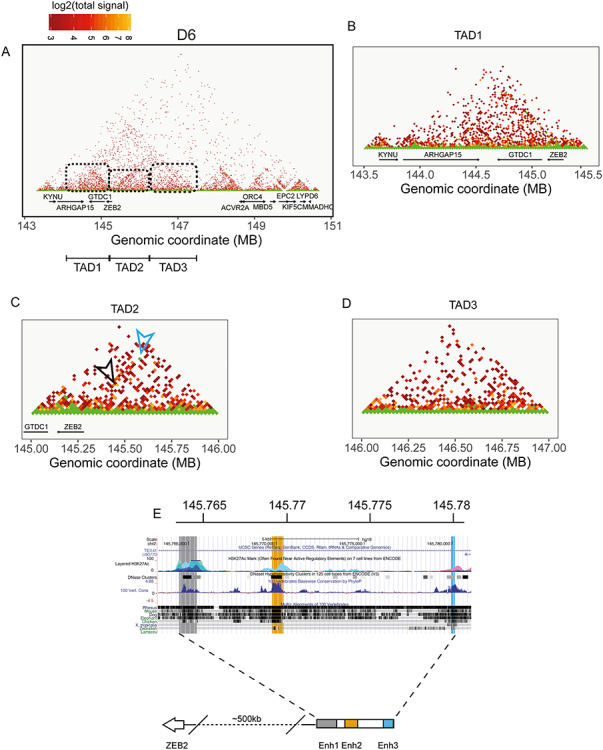
The main 143–147 Mb TAD defined at D6 is composed of three sub-TADs. At D6 (A), the major chromatin conformation encompassing the ZEB2 locus and upstream region is evident, displaying more intragenic proximity interactions and also three well-defined TADs located between ARHGAP15 and ZEB2 (TAD1, B), between 145 and 146 Mb (TAD2, C) and a third one located in the ZEB2 upstream gene desert between 146 and 147 Mb. At D6, the strongest signal is observed in a TAD structure defined by region coordinates 145260000–145280000 to 145760000–145780000 (D). Zooming-in on the coordinates chr2:145760000–145780000 allows the definition of three possible well conserved enhancers defined by H3K27Ac (E).